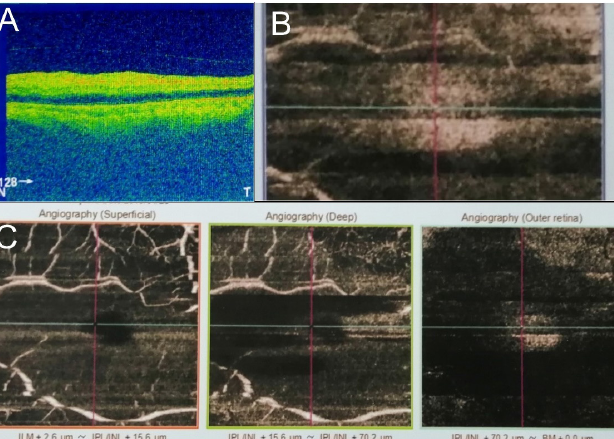
Figure 2. A- Optical coherence tomography images of posterior segment of the left eye- The horizontal cross-sectional image demonstrates increased